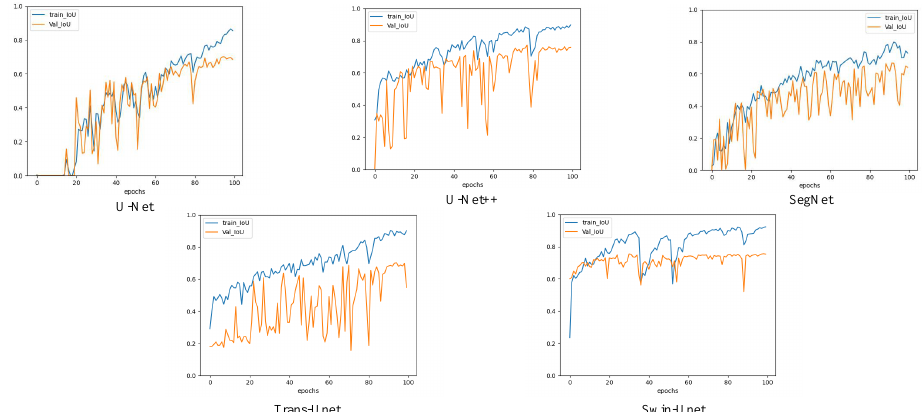
Figure 9. A comparison of the image segmentation results of the IOU curves of deep learning on pixel-level training and validation